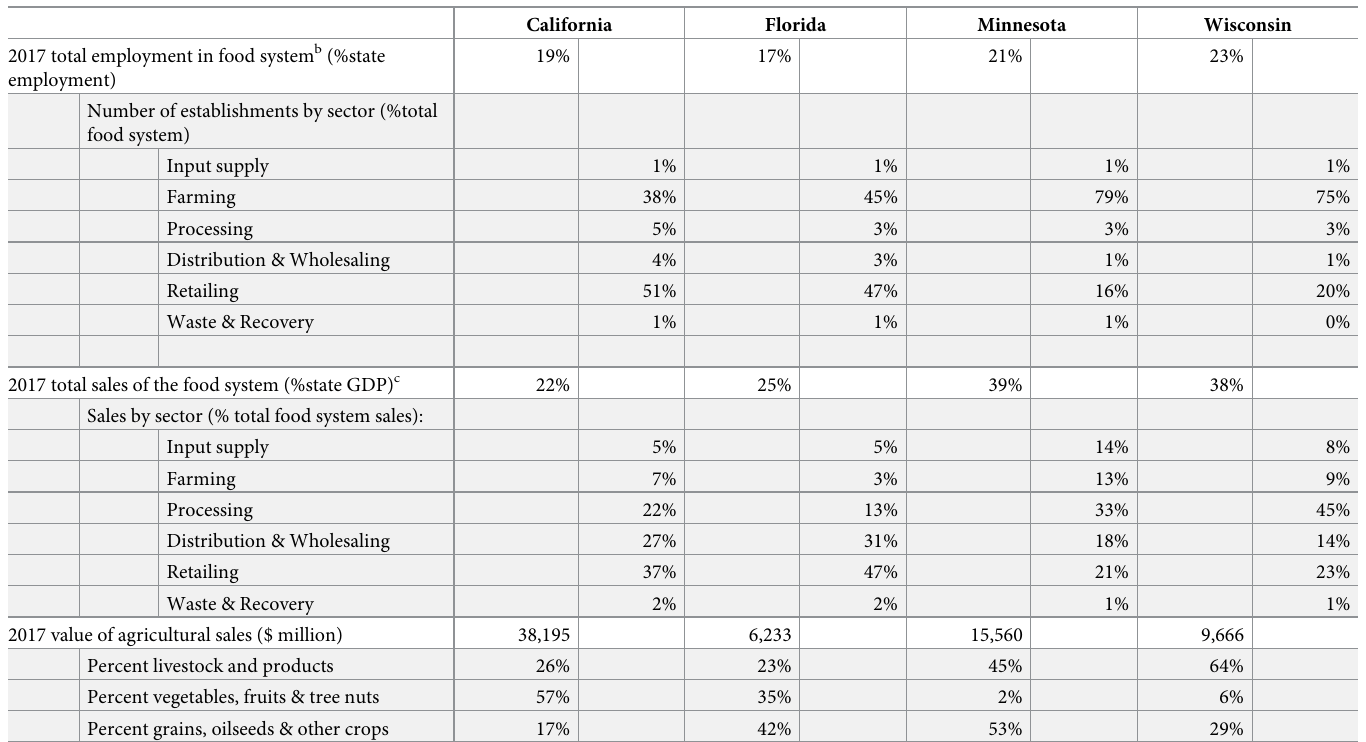
Table 1. Characteristics of the regional agri-food system, by study region a